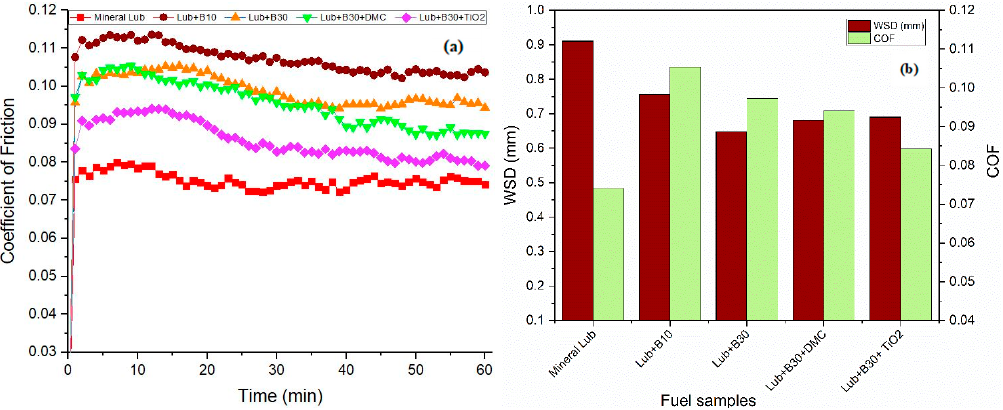
Tribological behavior: ( a ) COF and ( b ) WSD of mineral lubricant and lubricant contaminated samples.